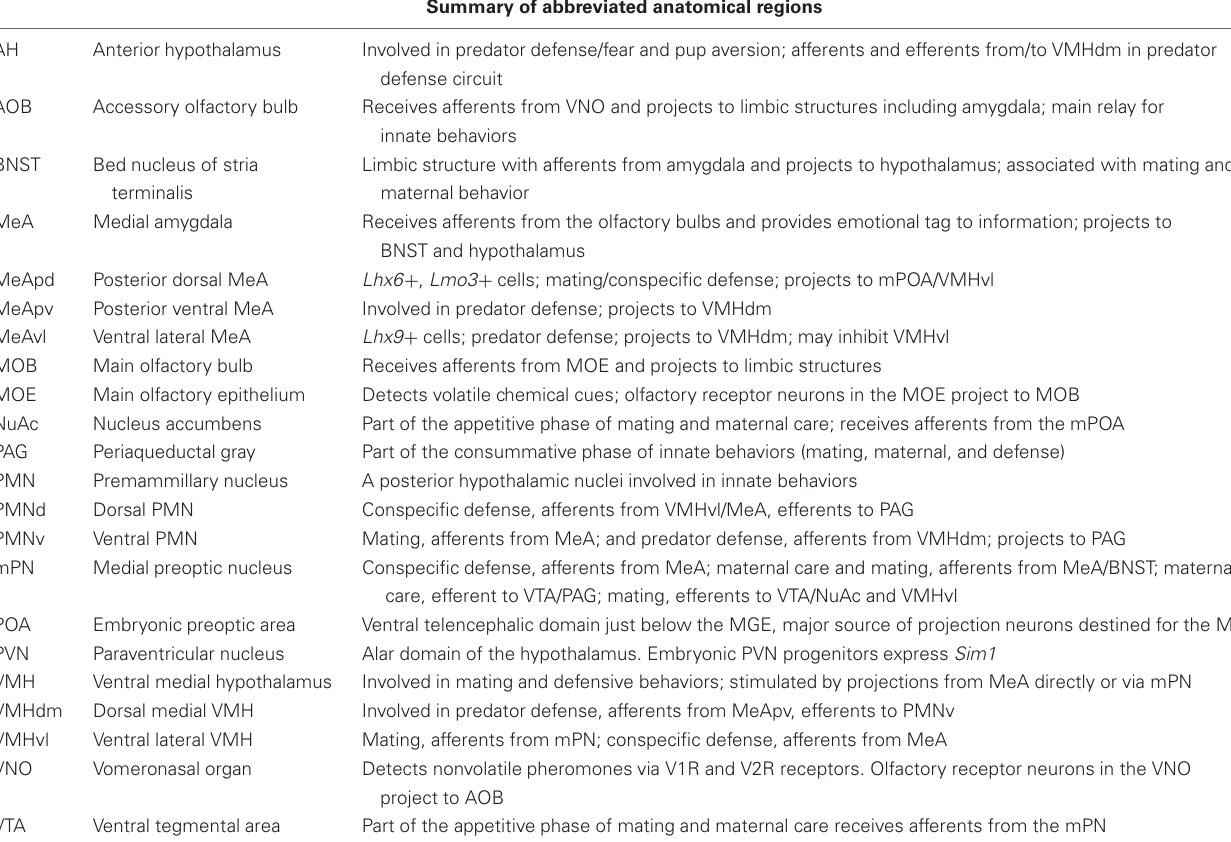
Table 1 | Abbreviations of limbic structures and summary of their role in innate behaviors. Summary of abbreviated anatomical